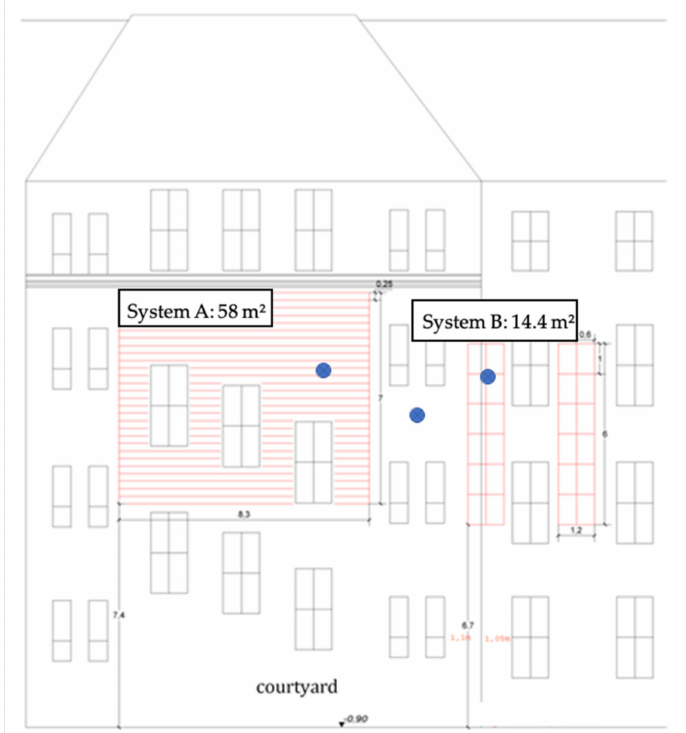
Figure 2. View of the south façade with the positions of the greening systems (red lines) and the measurement positions (blue dots) within the inner courtyard at the school GRG7 Kandlgasse in Vienna.